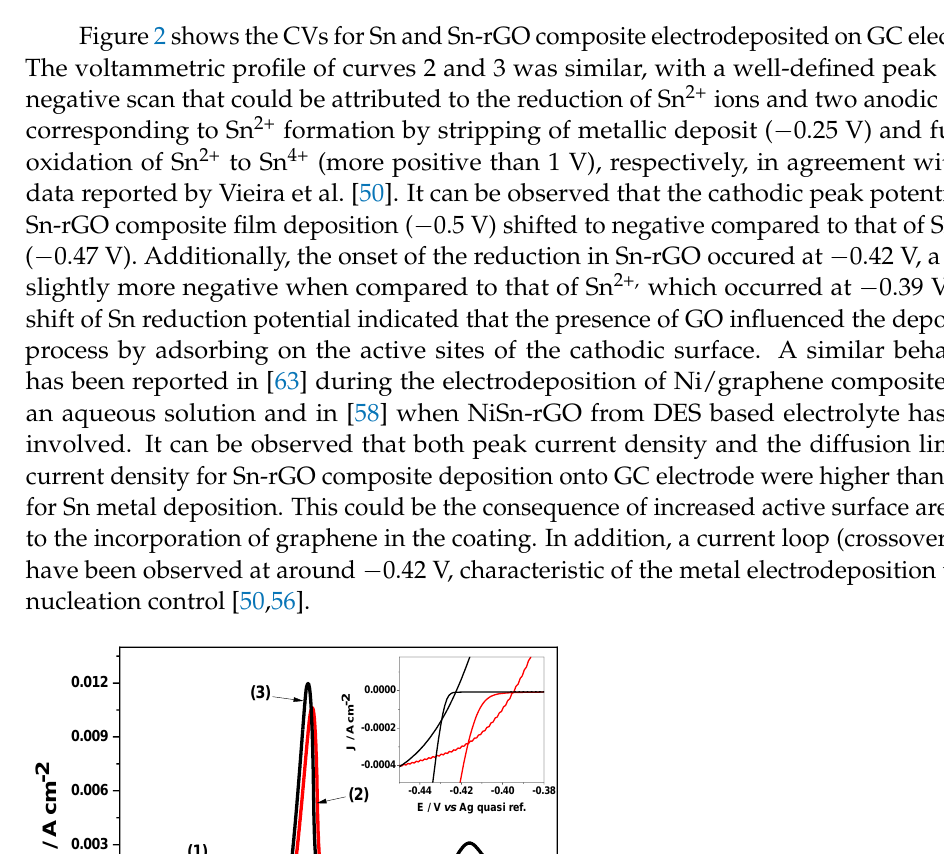
Figure 1. Cyclic voltammograms (CVs) on GC working electrode at 20 mV s − 1 in ILEG and ILEG containing 20 mg L − 1 GO, 25°C.